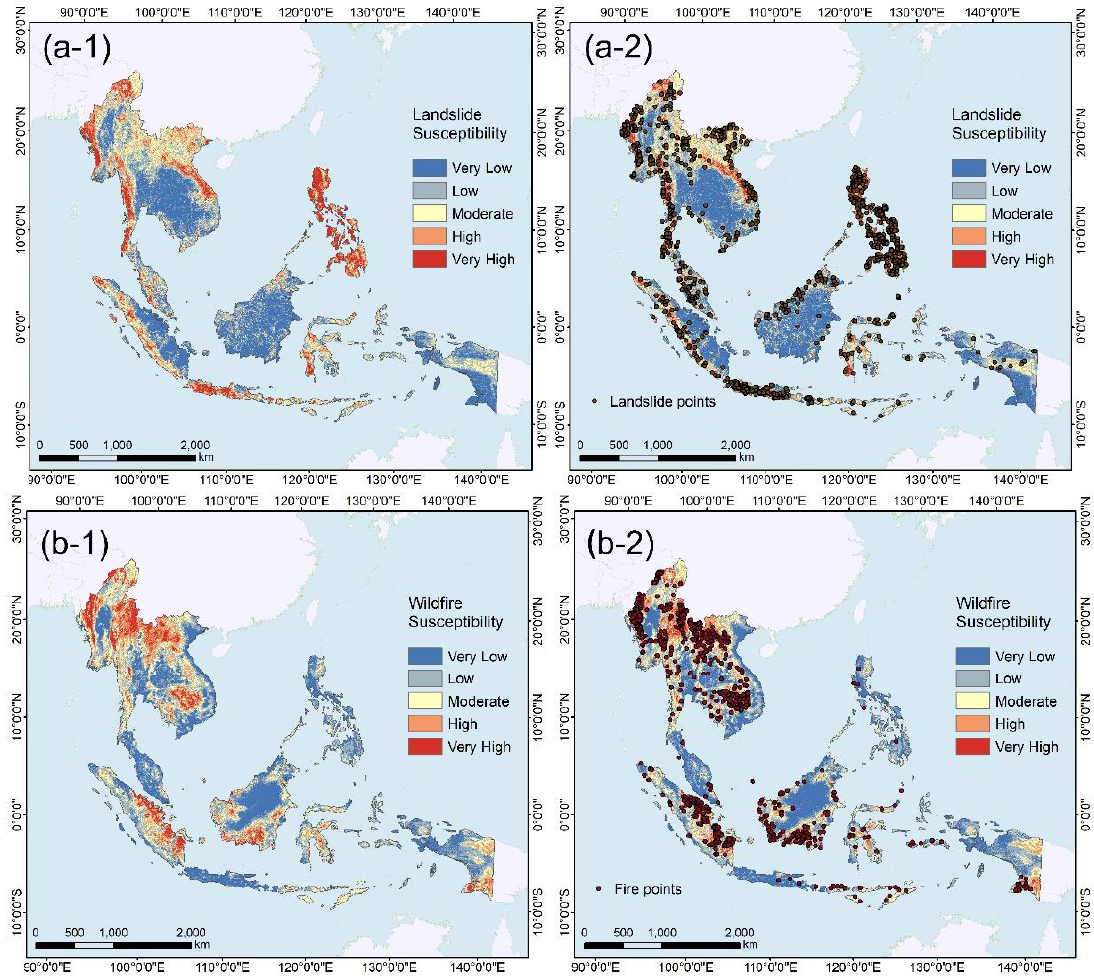
Figure 5. Susceptibility map using the RF model: ( a ) landslides and ( b ) wildfires.